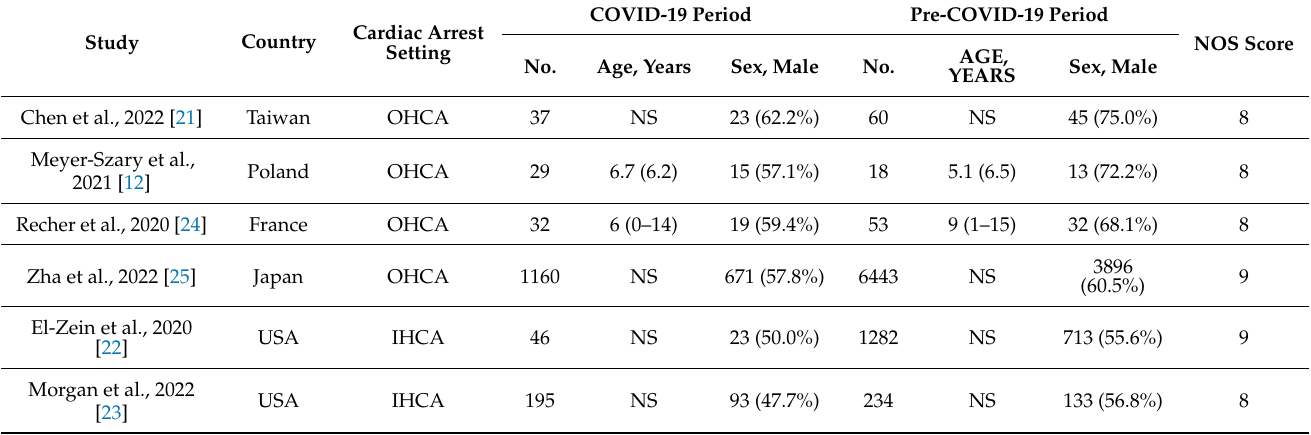
Table 1. Characteristics of included